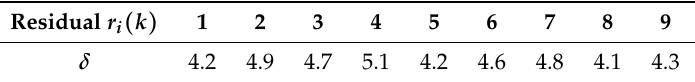
Table 8. δ values for the threshold logic.